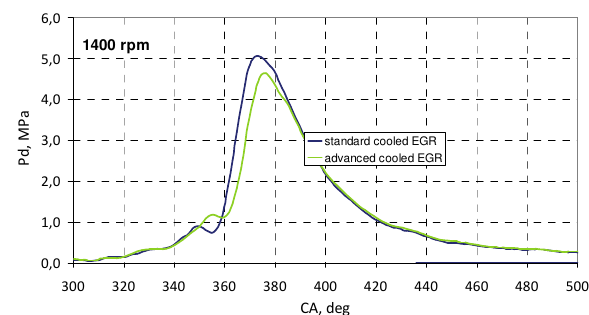
Fig. 23. Impact of EGR cooling system at MBF specific values (engine rotational speed: 1400 rpm, 190 Nm load)